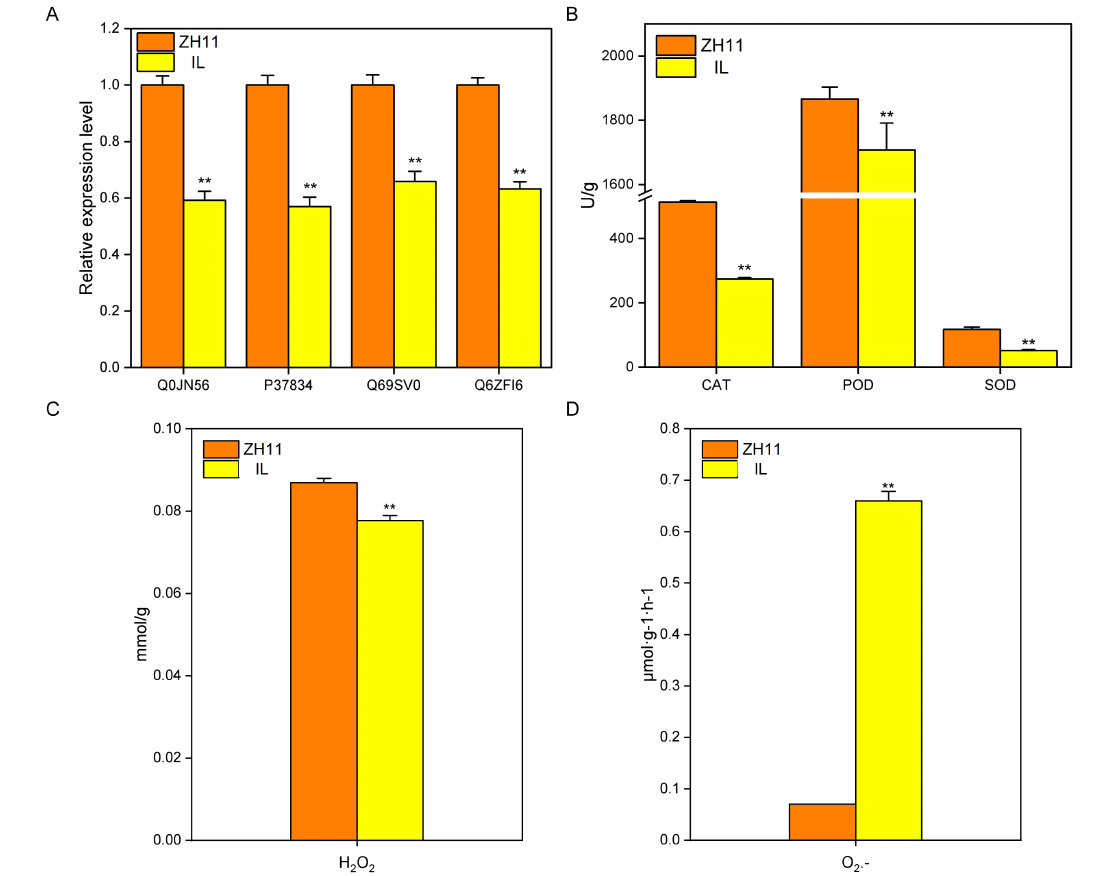
Figure 6. Analysis of reactive oxygen species pathways. ( A ) DEPs of peroxisome proteins in IL and ZH11. ( B ) ROS scavenging enzyme content. “U” for CAT: the degradation of 1 µ mol H 2 O 2 per minute per gram of tissue in the reaction system is defined as an enzyme activity unit; “U” for POD: A470 change of 0.01 per minute per gram tissue in each mL reaction system is defined as an enzyme activity unit; “U” for SOD: the amount of enzyme required to inhibit 50% photochemical reduction of Nitrotetrazolium Blue chloride (NBT) was 1 enzyme activity unit. ( C ) H 2 O 2 content of IL and ZH11. ( D ) O 2 − generation rate of IL and ZH11. The data represent the mean ± SD ( n = 3), ** p ≤